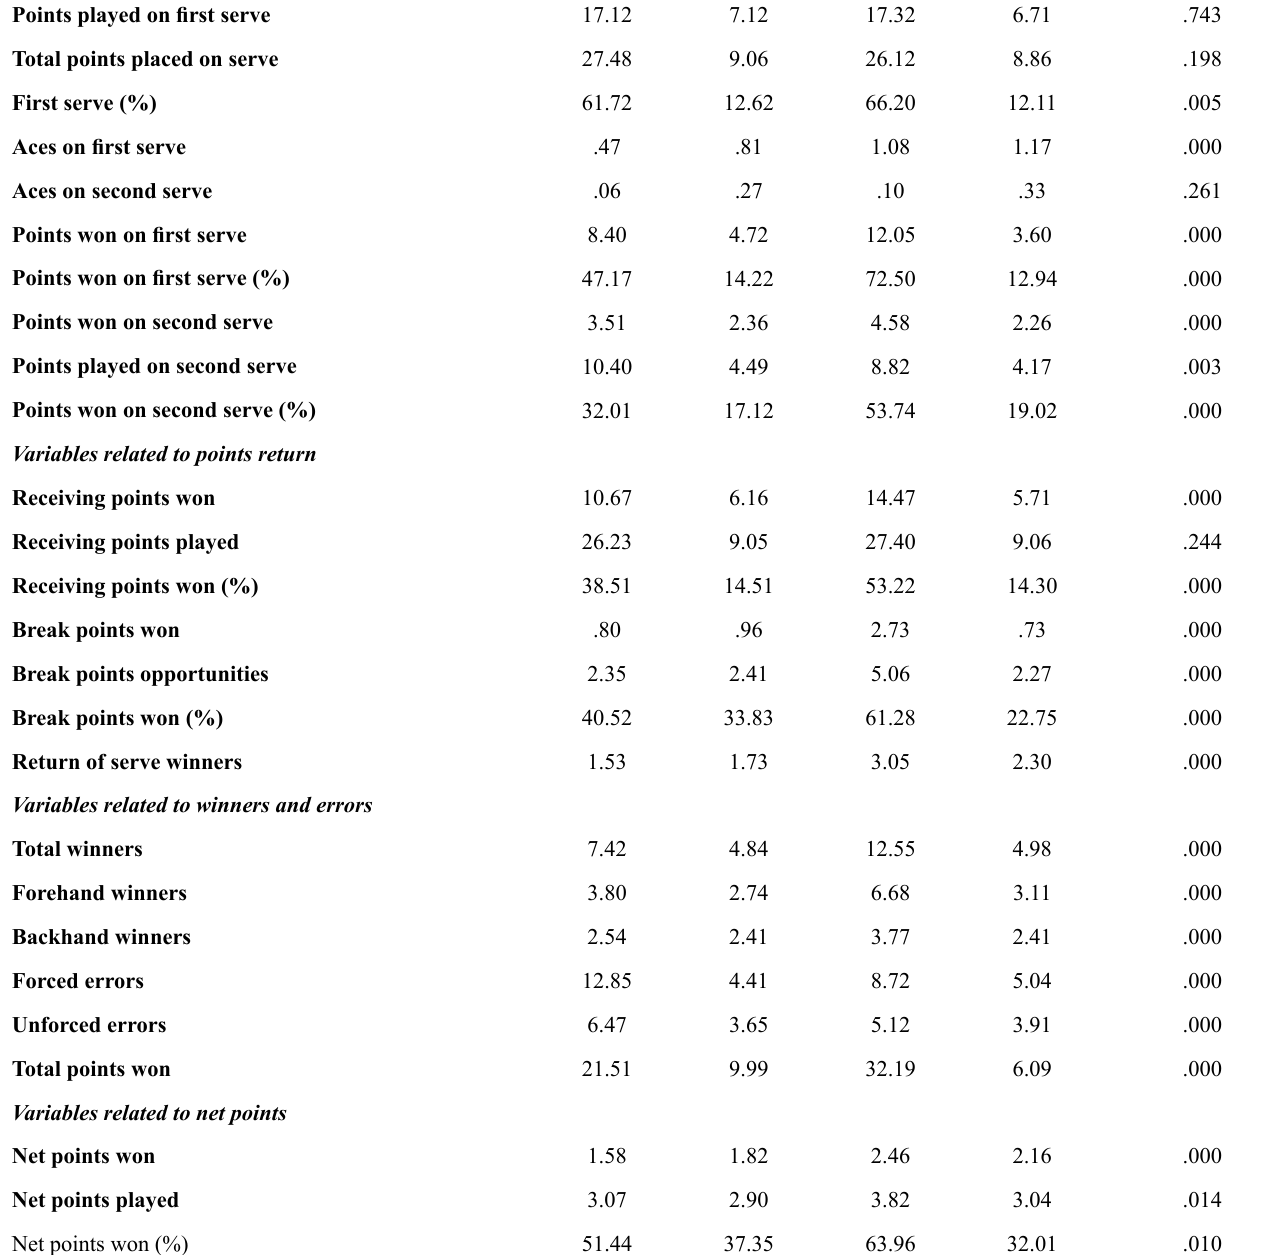
Short title: Game statistics in wheelchair tennis in Paralympics Games